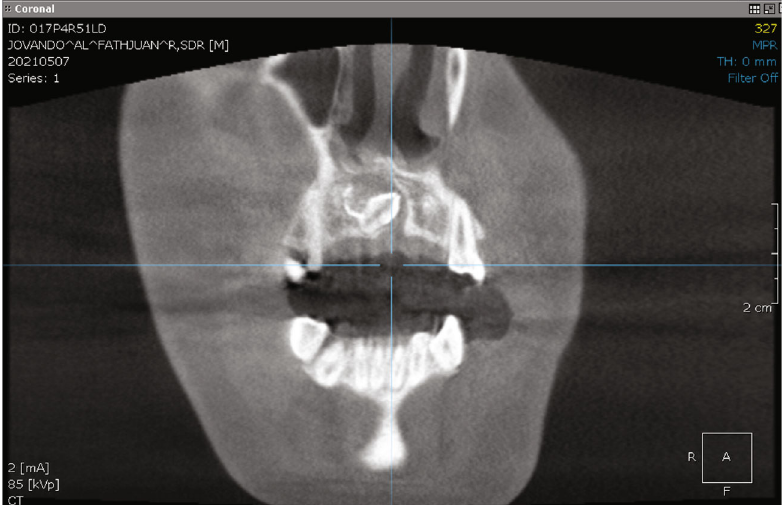
Figure 3: CBCT radiographic view. The mesiodens impacted tooth was seen between teeth 11 and 21 in an inverted position. Mesiodens tooth distance with the base of the nasal cavity: 3.93mm. A mixed radiolucent-radiopaque image is seen around the crown of the mesiodens with a clear border with radiopaque edges and an oval shape. The lesion appears to cause a discontinuity of the palatal cortical bone, and the lesion is in contact with the fl oor of the nasal cavity.